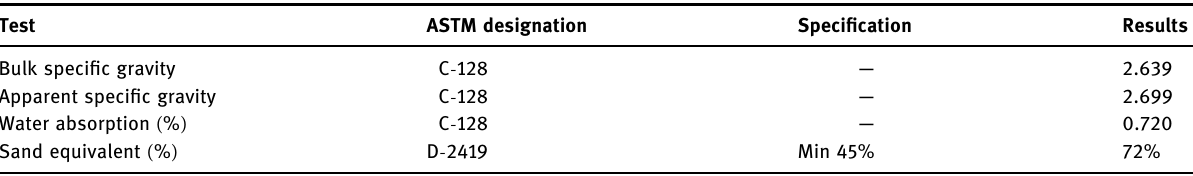
Table 2: Physical characteristics of fi ne aggregate crushed sand